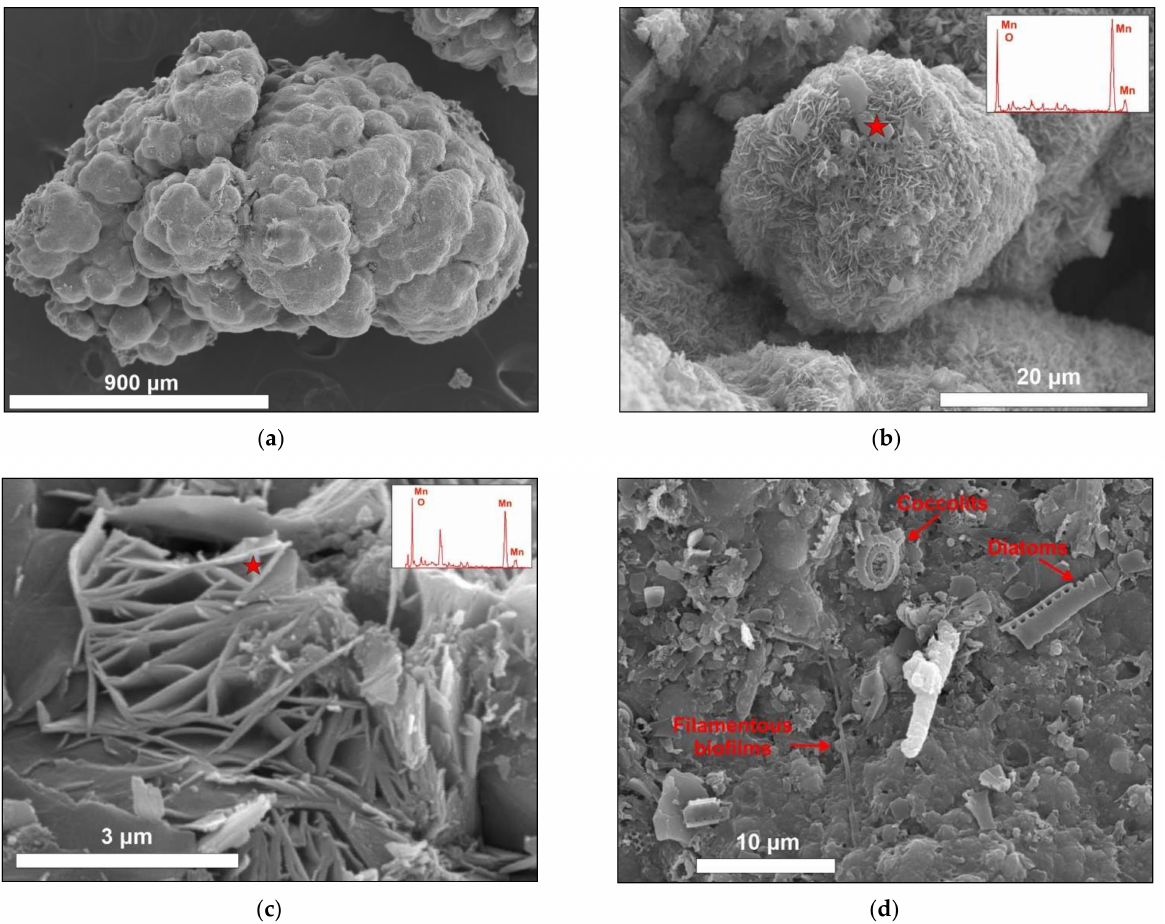
Figure 3. Selected SEM photomicrographs of Mn-(Fe)oxyhydroxides indicating distinctive textural features: ( a ) micro-botryoidal surface in the sample SIO0000BP; ( b ) pure Mn-oxyhydroxides forming radial and globular micro-aggregates (rosette-type) in the sample SIO00003U; ( c ) micro-crystals of with clay-like morphologies in the sample SIO0000BP; ( d ) Mn-(Fe) oxyhydroxides covering bioclasts and filamentous biofilms in the sample SIO0000BQ, including remnants of diatoms and coccoliths. Red star symbols indicate points of energy dispersive X-ray spectroscopy